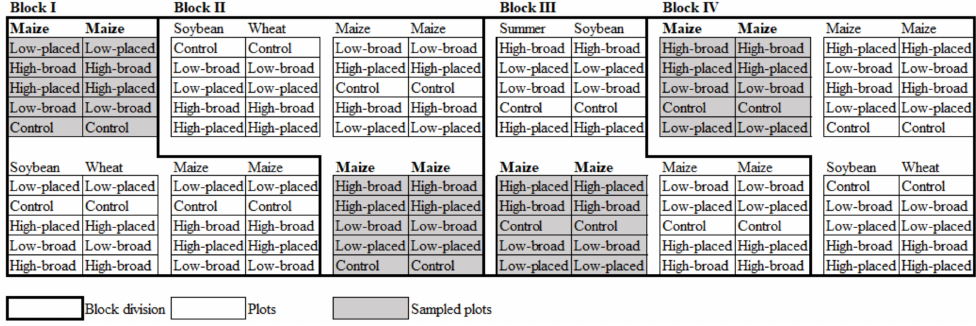
Figure 1. Experimental design and sample collection in the field season of